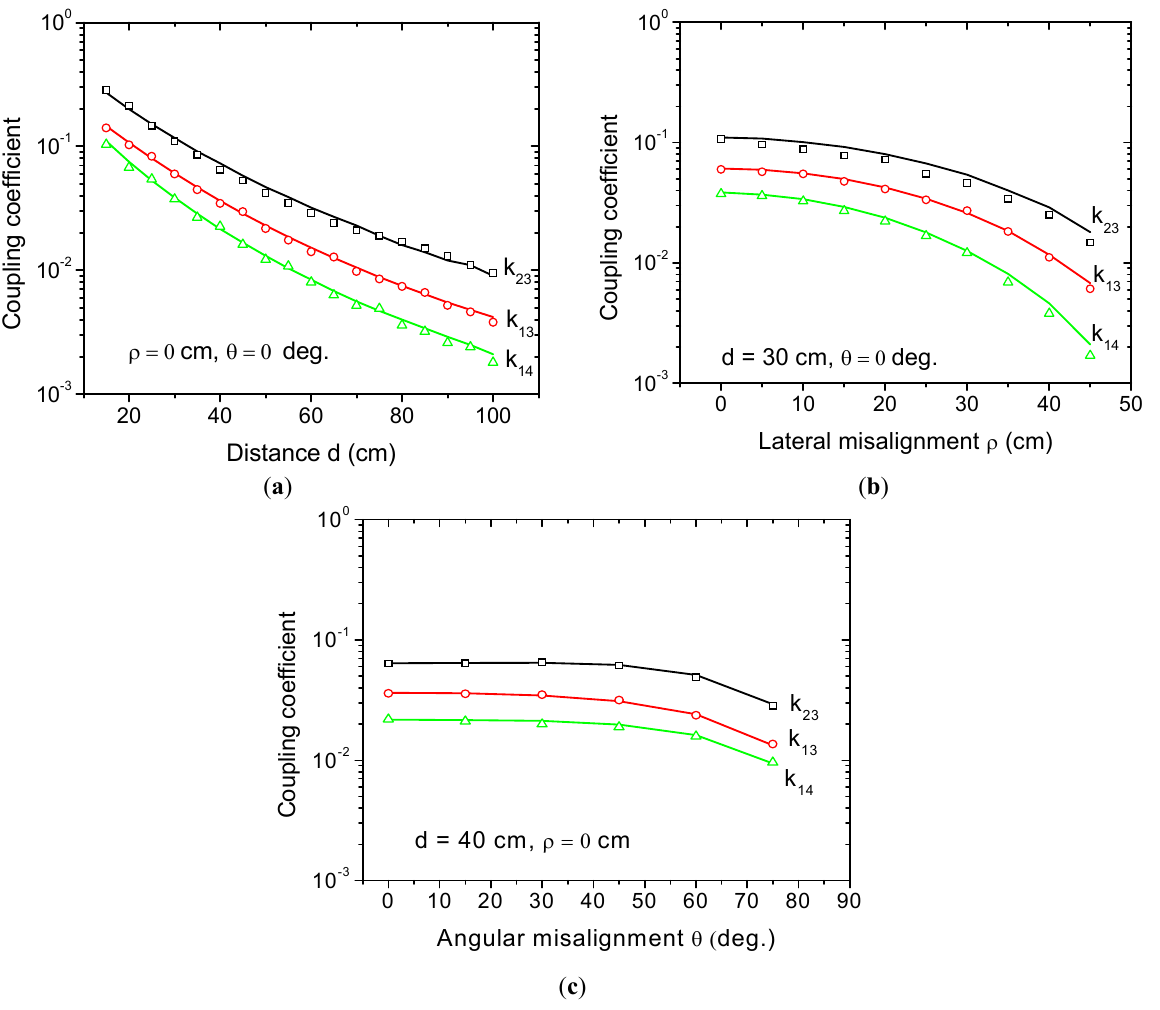
Figure 4. Measured (symbol) and calculated (line) coupling coefficients as functions of ( a ) distance; ( b ) lateral misalignment; and ( c ) angular misalignment.